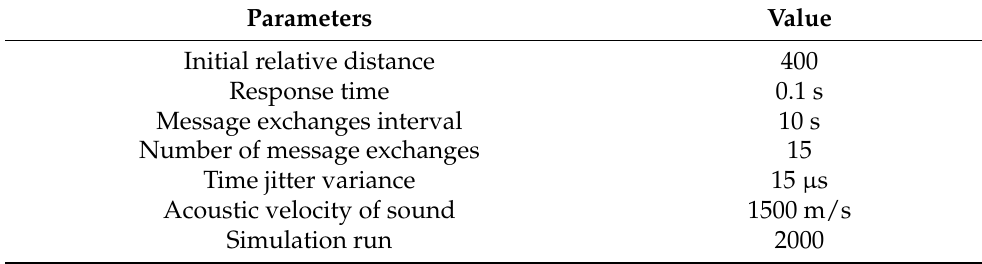
Table 1. Simulation Parameter